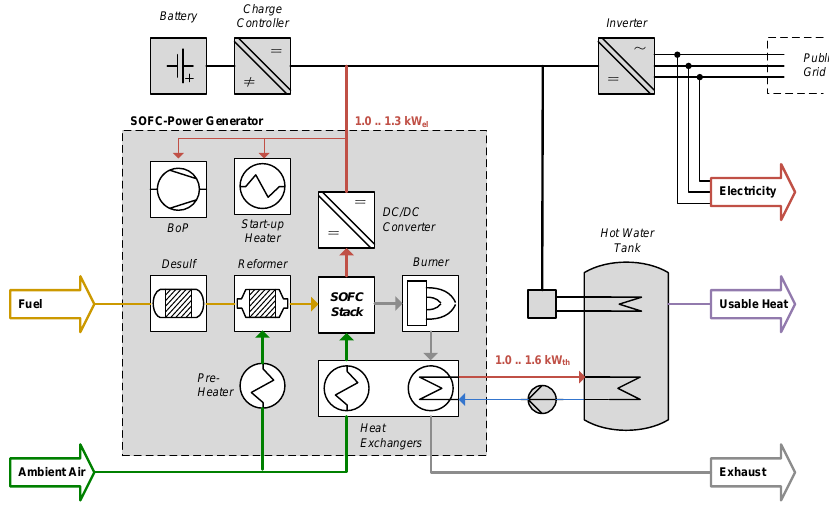
Figure 3. Schematic representation of the SOFC hybrid system with a 1 kW el SOFC power generator based on partial oxidation of natural gas with optional heat